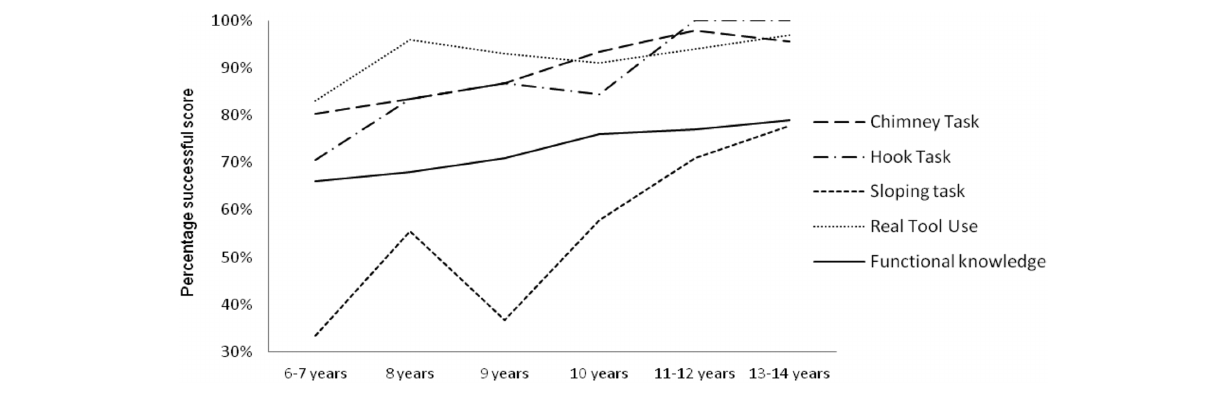
Models were ranked in relation to each other using (cid:49) AICc values [ (cid:49) i = AICc(i) – AICc(min)]. Akaike weights were computed ( ω